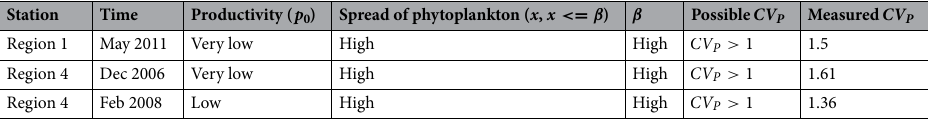
Table 5. CV P > 1 : nature of phytoplankton productivity and spreading triggered by regional and seasonal impact.